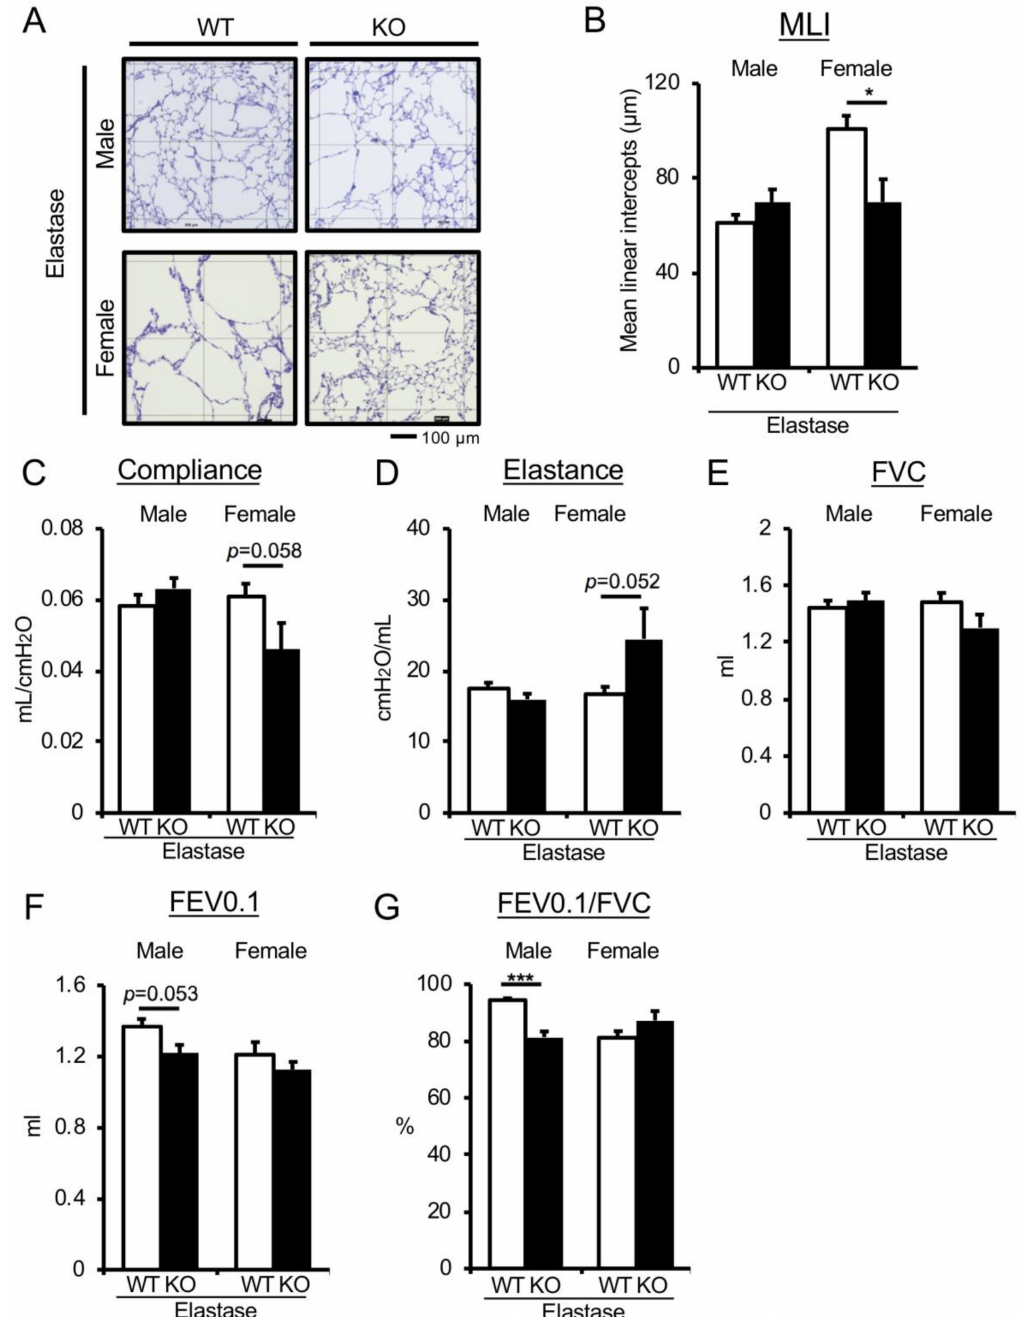
Figure 2. Genetic depletion of Uox in elastase-induced chronic obstructive pulmonary disease (COPD) mice improves the emphysematous phenotype in a female-specific manner. ( A ) Emphysematous phenotypes in elastase-treated male and female WT and Uox-KO mice. PAS-stained lung section. Square diameter = 300 µ m. Scale bar = 100 µ m. ( B ) Quantitative morphometric analysis of alveolar septa. n = 5–7 mice / group. * p < 0.05, versus elastase-treated WT; Student’s t -test. ( C – G ) Parameters of pulmonary function are indicated (compliance, elastance, FVC, FEV0.1, FEV0.1 / FVC) in elastase-treated male and female WT and Uox-KO mice. n = 5–8 mice / group. *** p < 0.001, versus elastase-treated WT; Student’s t test. Data expressed as mean ±